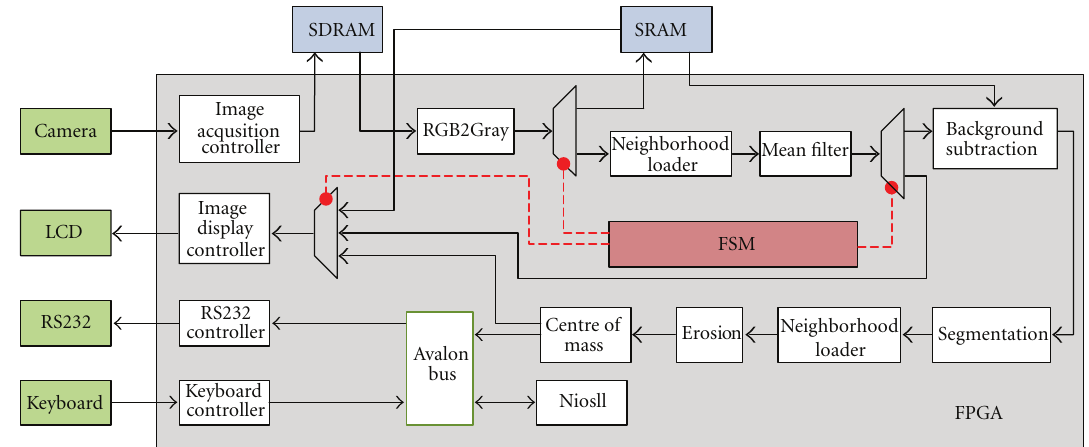
Figure 10: Hardware implementation of the image acquisition